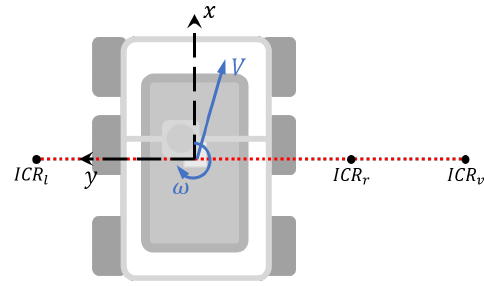
Figure 5. ICR on the vehicle